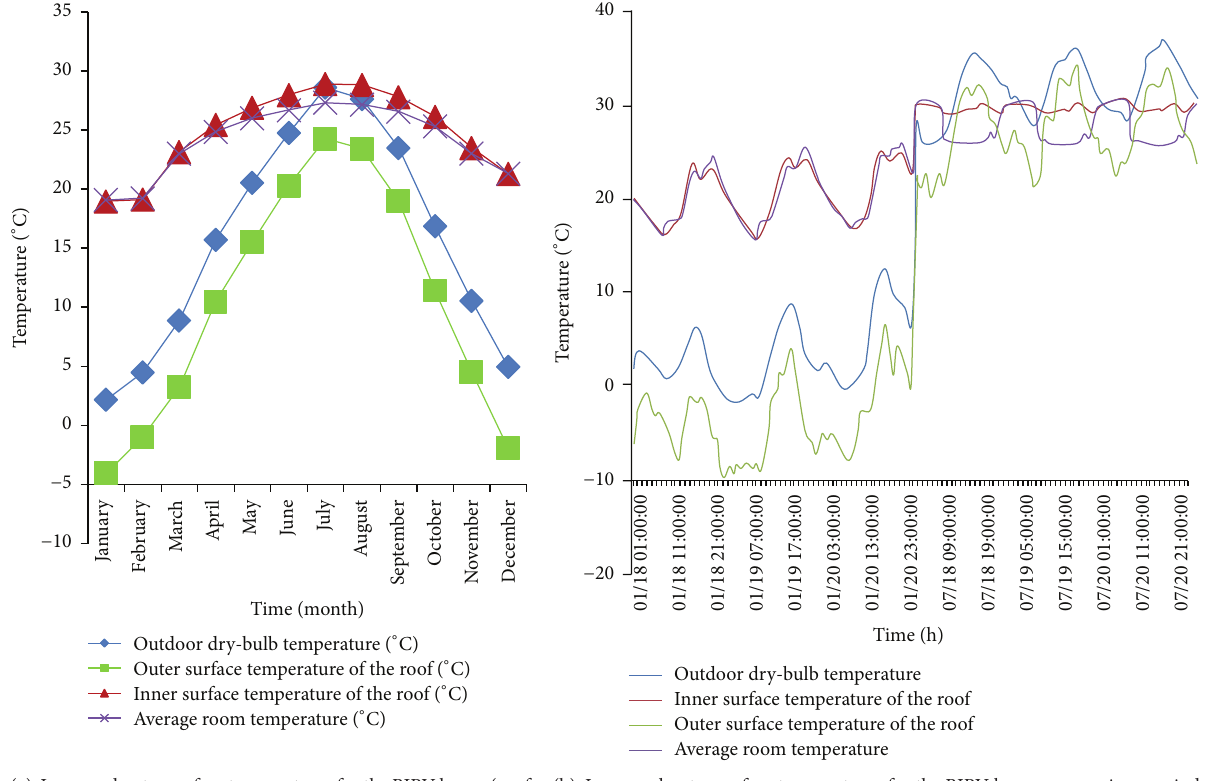
(b) Inner and outer surface temperatures for the BIPV house over a given period of time during winter and summer (roof 𝐾 = 0) Figure 8: Simulated inner and outer surface temperatures for the BIPV house (roof 𝐾 =